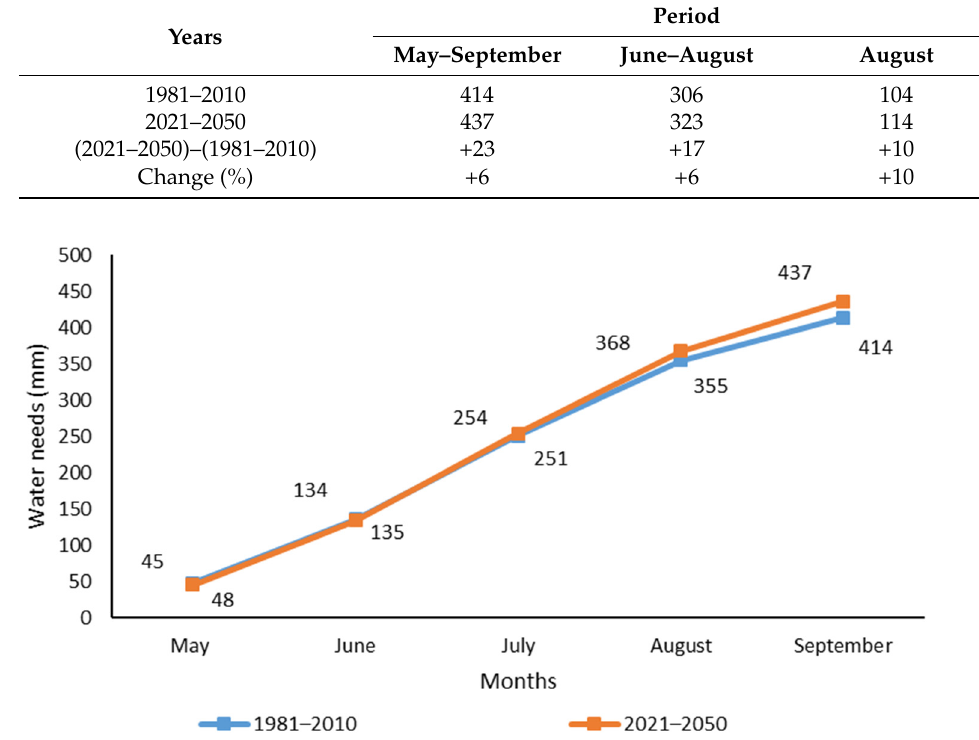
Figure 6. Cumulative sums of grapevines’ water needs during the growing season (May–Septem- ber) in the reference years (1981–2010) and in the forecast years (2021–2050).